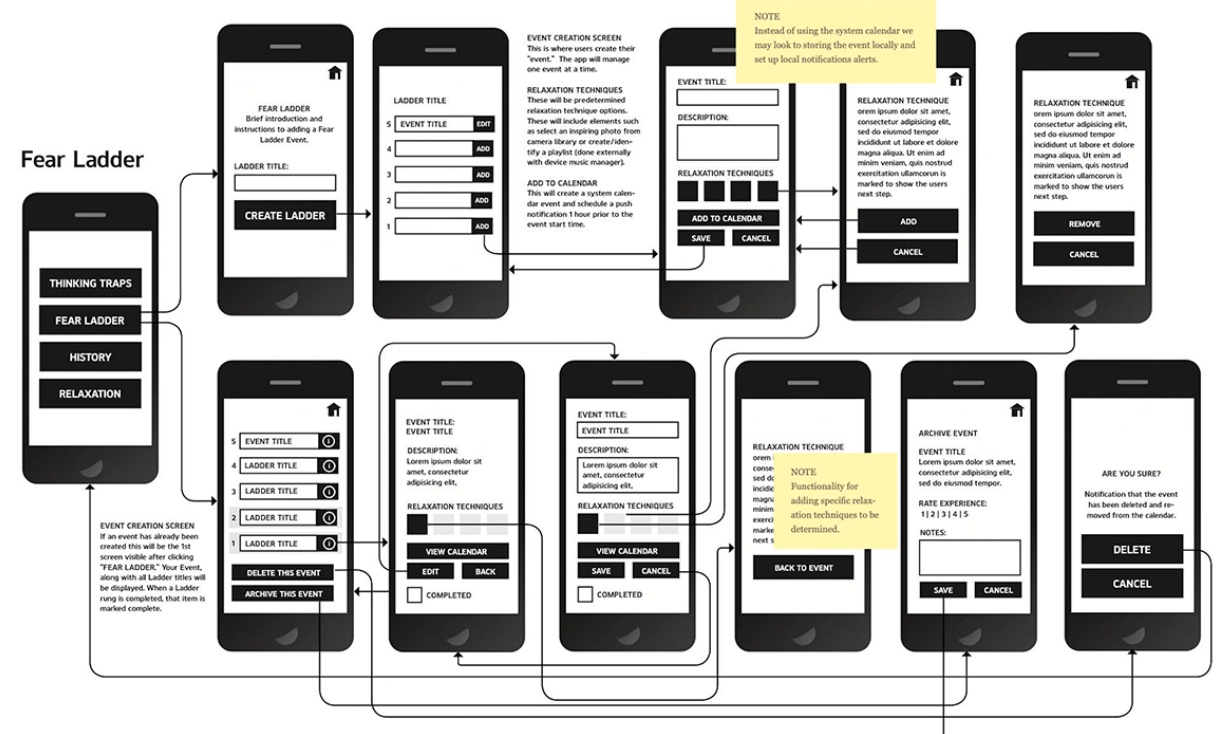
Figure 2. Screenshot of an initial MindClimb wireframe.